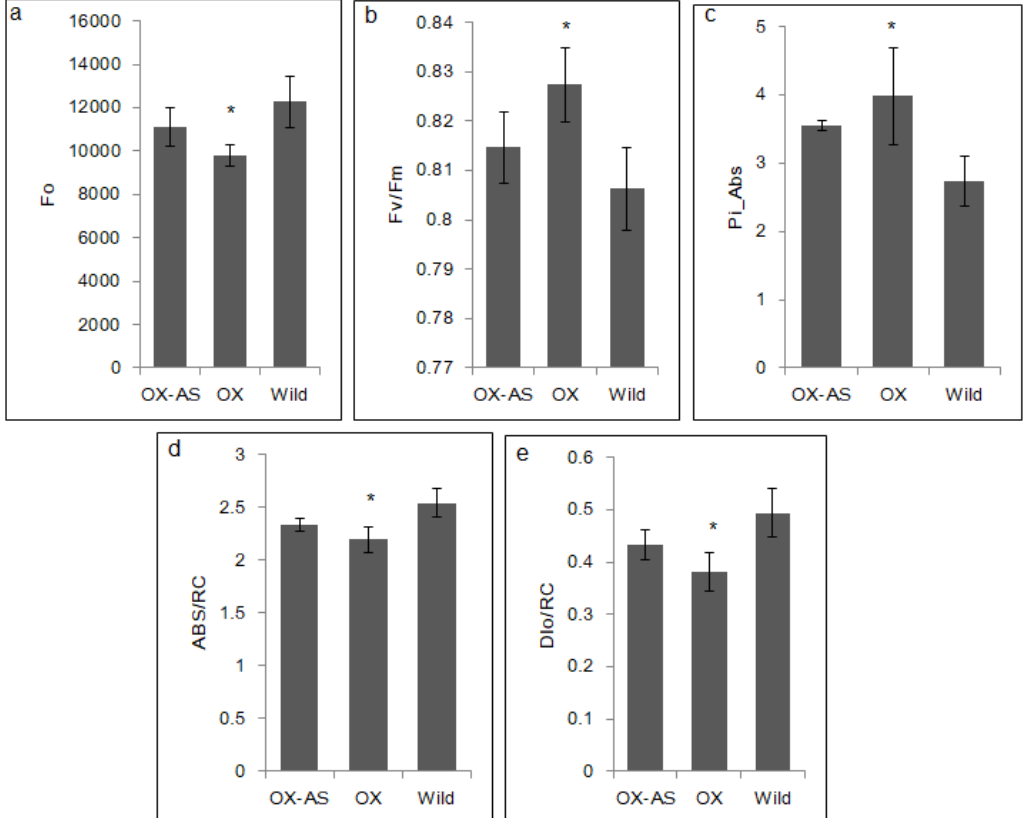
Figure 5. Comparison of chlorophyll fluorescence transients of dark-adapted leaves of BrEXLB1 sense (OX), antisense (OX-AS), and wild type B. rapa plants subjected to 8 days of progressive drought stress conditions. ( a – e ) represent initial fluorescence (Fo), maximum quantum yield of primary chemistry (Fv / Fm), performance index (Pi-Abs), absorption per reaction center (ABS / RC), and dissipation per reaction center (DI 0 / RC) in PS II, respectively. * represents the statistical